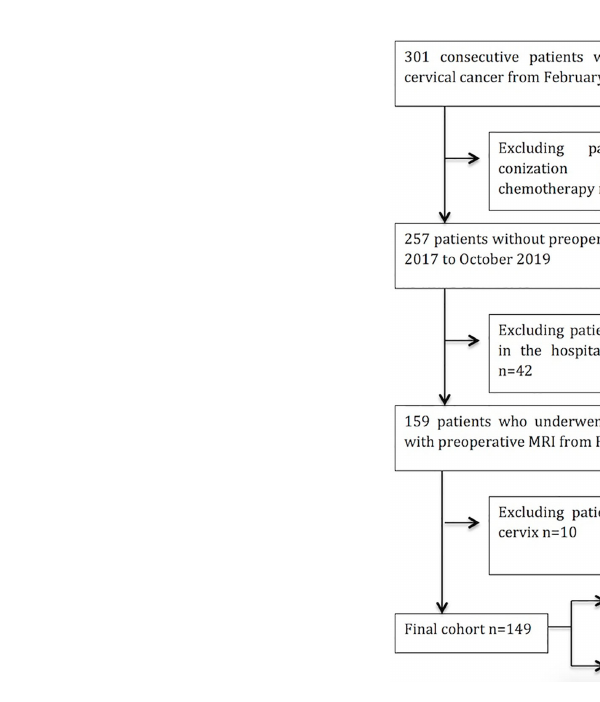
FIGURE 1 | Flow diagram of the study enrollment patients.